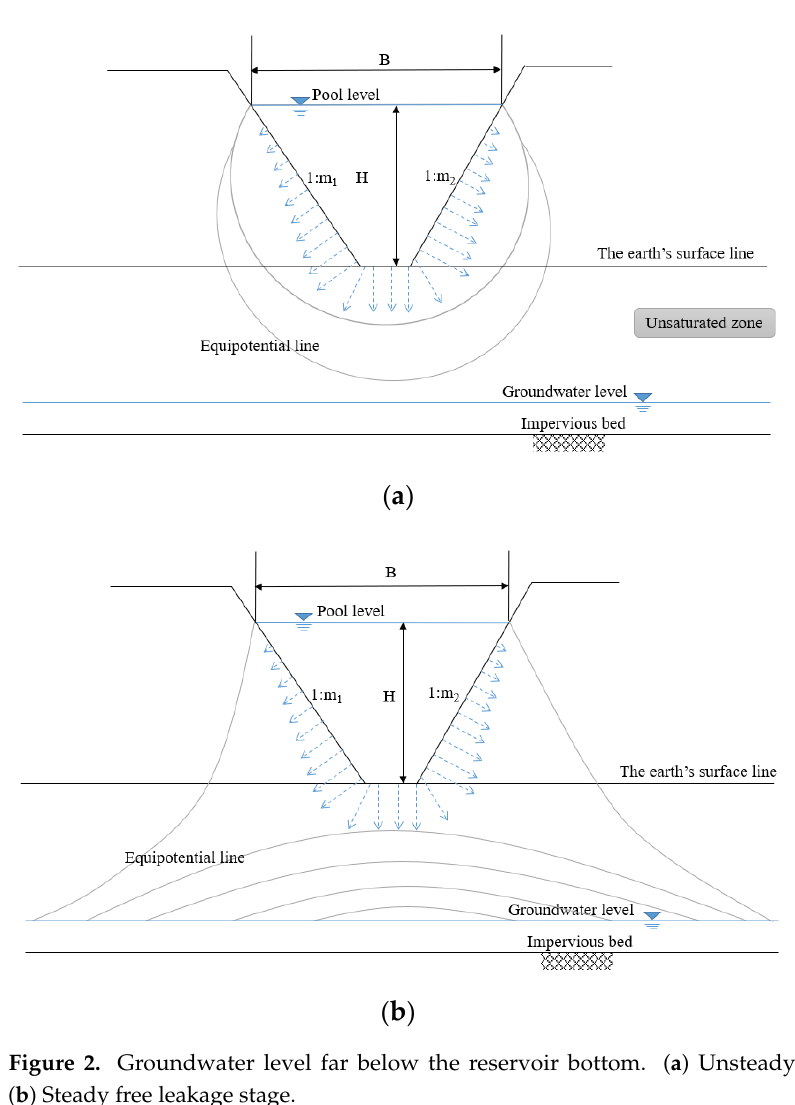
Figure 2. Groundwater level far below the reservoir bottom. ( a ) Unsteady free leakage stage. ( b ) Steady free leakage stage.